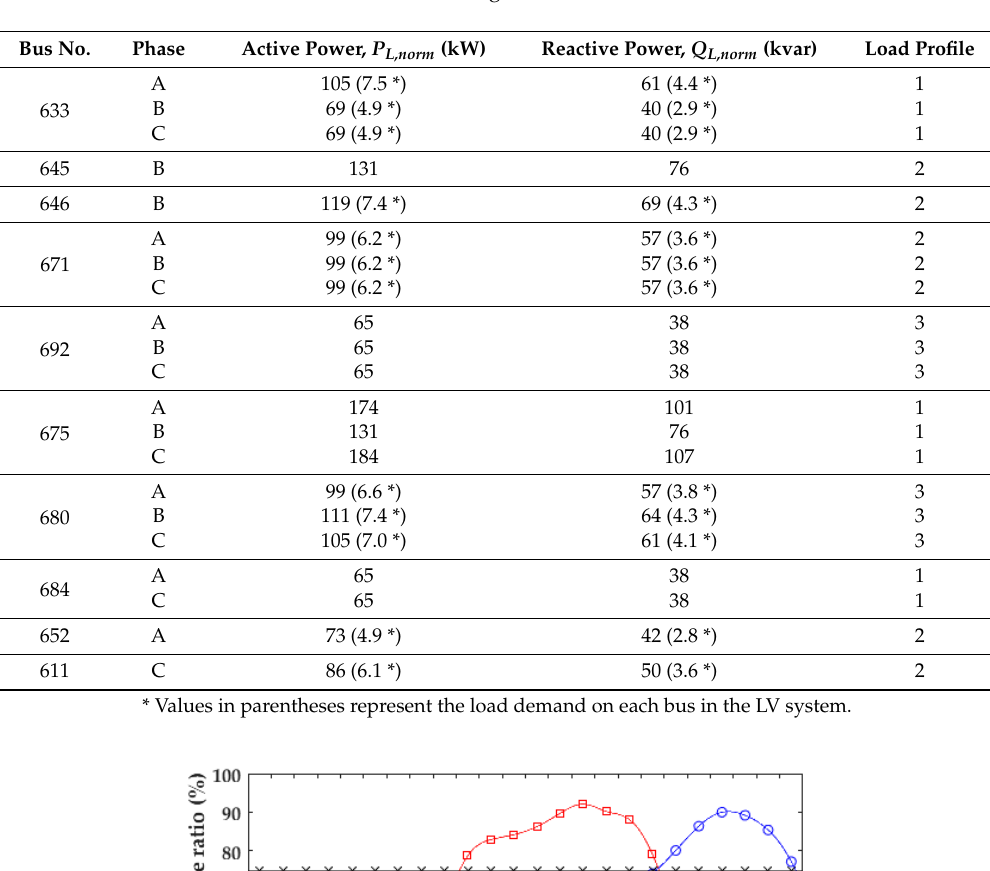
Table 3. Average load demand.